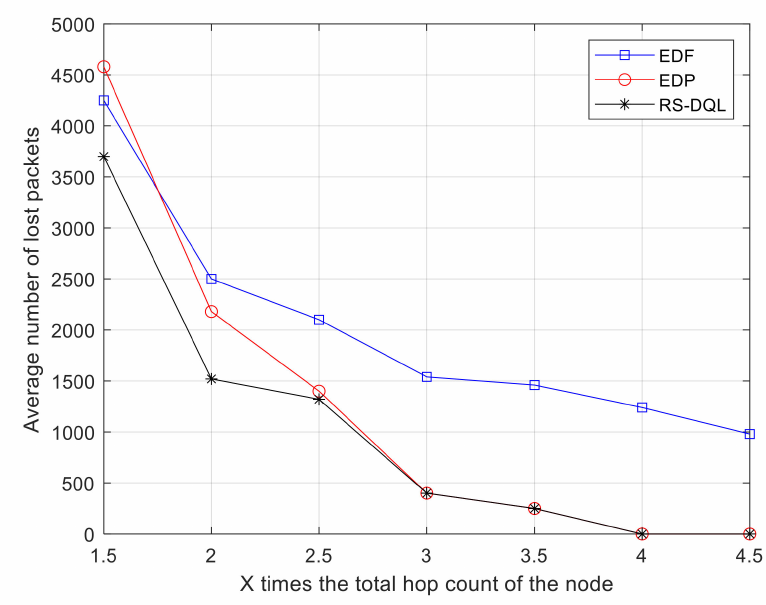
Figure 6. The number of lost packets as the data generation period increases.